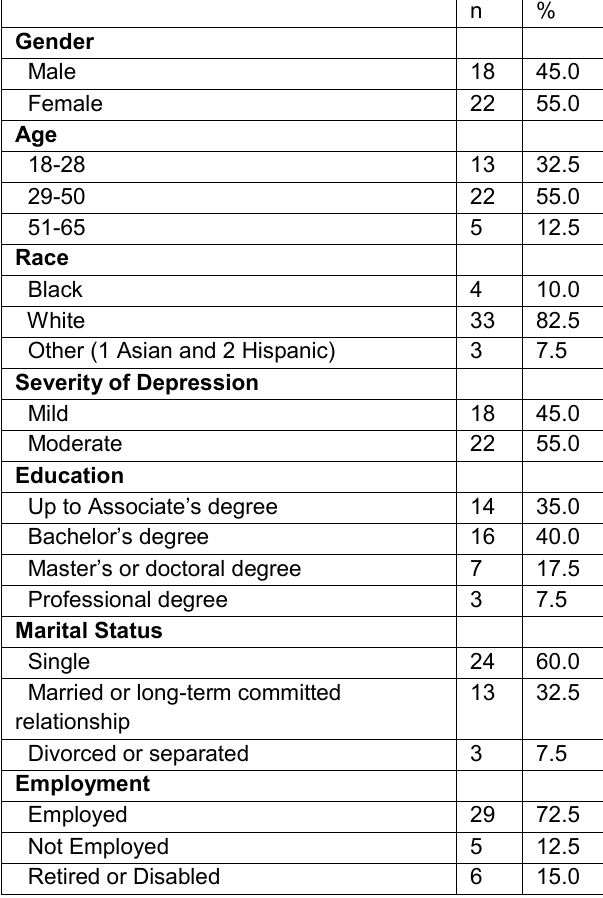
Demographic Information of the Study Participants